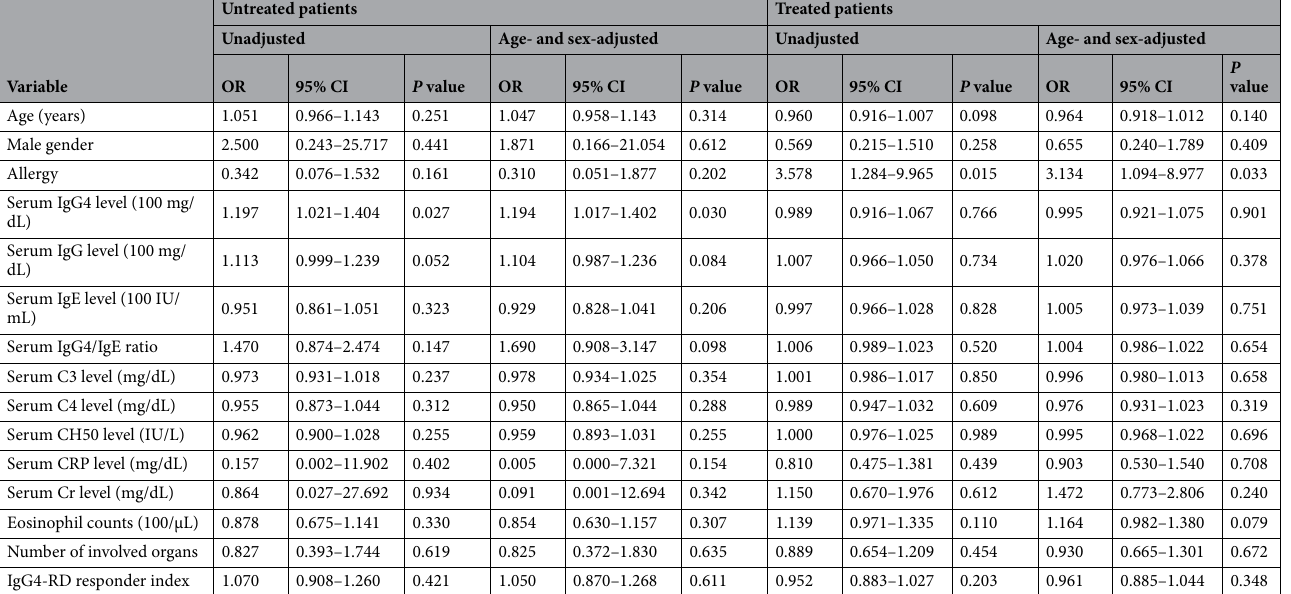
Table 4. Odds ratio for risk of deterioration of IgG4-RD: unadjusted and age- and sex-adjusted logistic regressions. Conversion factor for Cr: mg/dL to μmol/L, × 88.4 ANA anti-nuclear antibody, Cr creatinine, CRP C-reactive protein, IgG immunoglobulin G, IgG4 immunoglobulin G4, IgE immunoglobulin